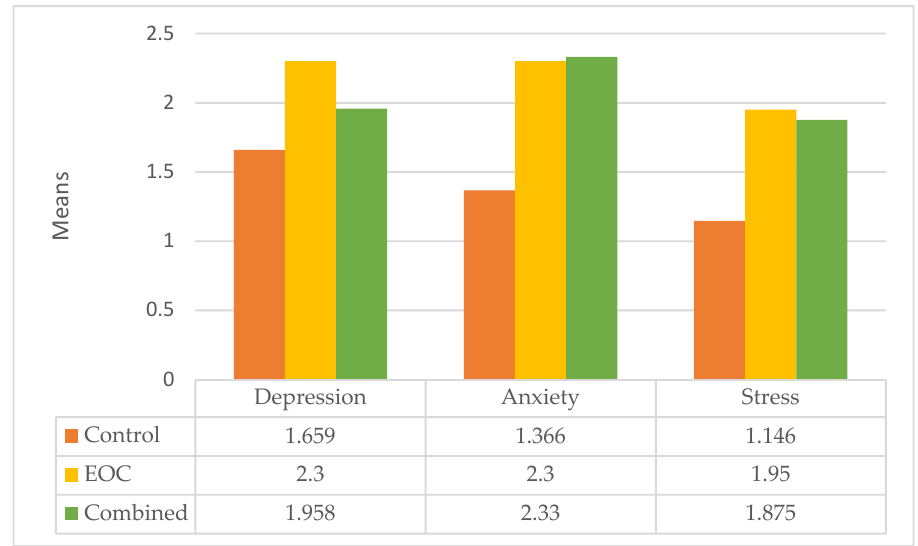
Figure 2. Psychological status of DASS-42 between each group.